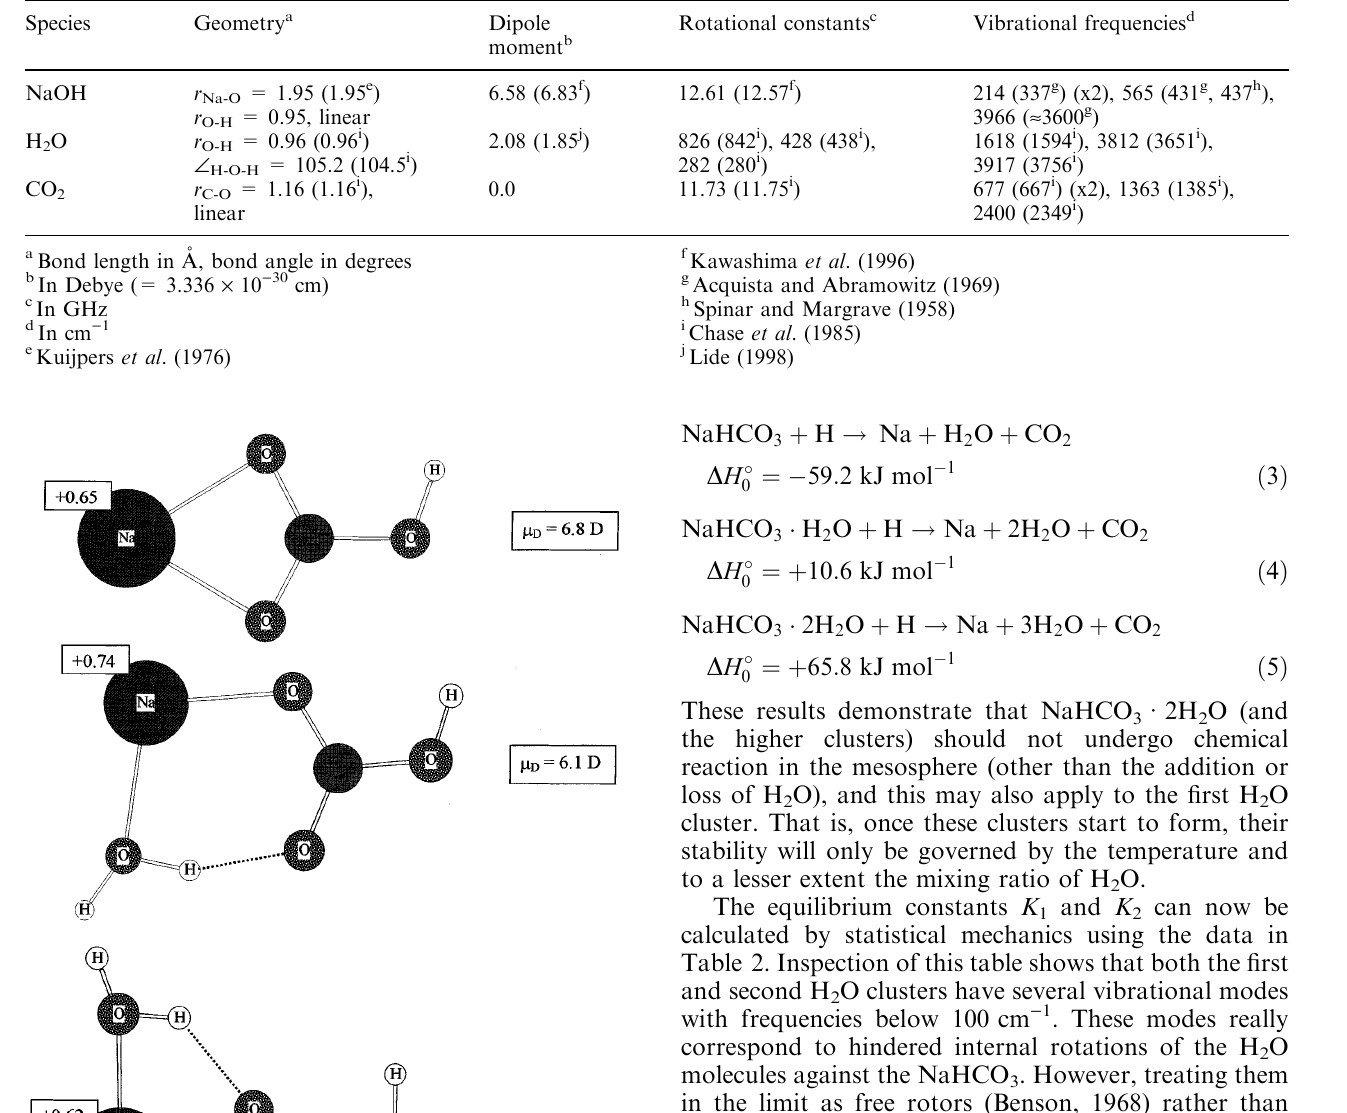
O and CO . For comparison, 2 2